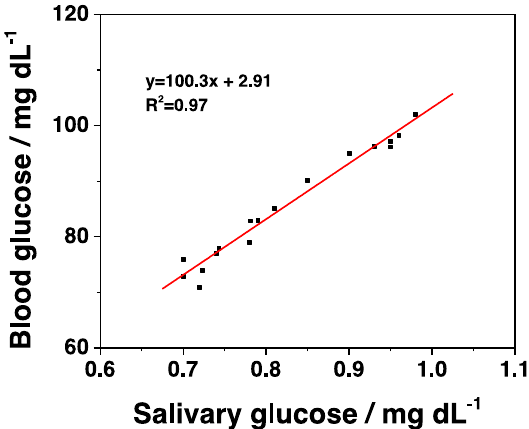
Figure 5. Correlation between glucose blood and saliva glucose concentration in 6 healthy patients at fasting state. Salivary glucose was detected with the Ct CDH C291Y/GA/4-APh,4-MBA/AuNPs/GC biosensor, blood glucose was detected with the commercial GlucoContour XT.